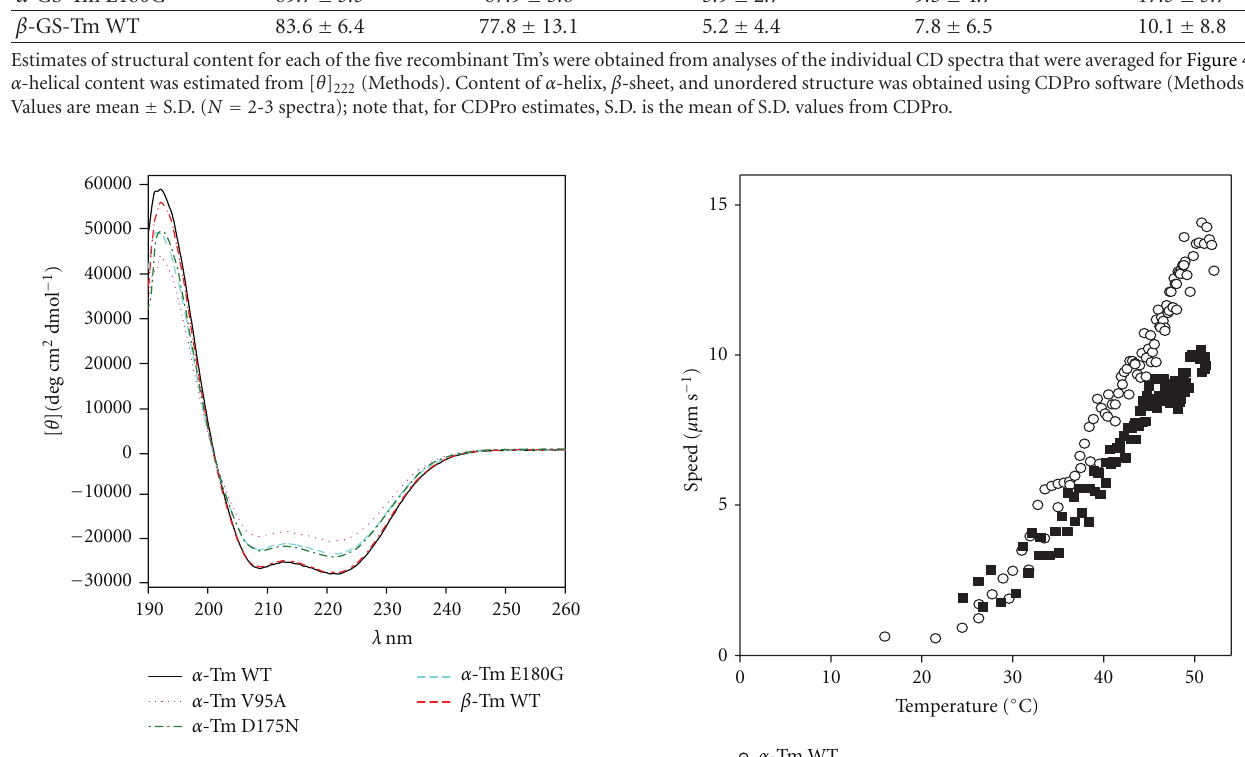
Figure 4: Circular dichroism spectra of WT and mutant recombi- nant tropomyosins in solution. Each spectrum is the average of 2- 3 independent determinations. Estimates of structural content are given in Table 2. Note that curves for α -GS-Tm WT and β -GS-Tm WT overlap over most of the wavelength range.